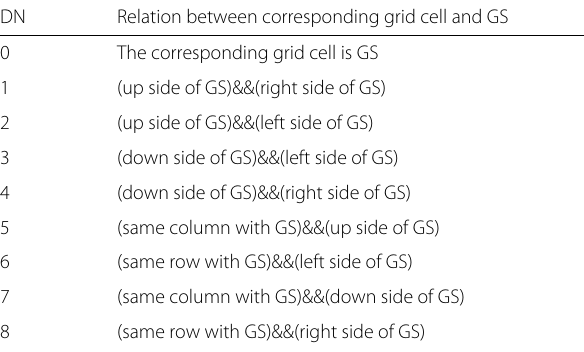
Table 2 The relation between grid cells DN and